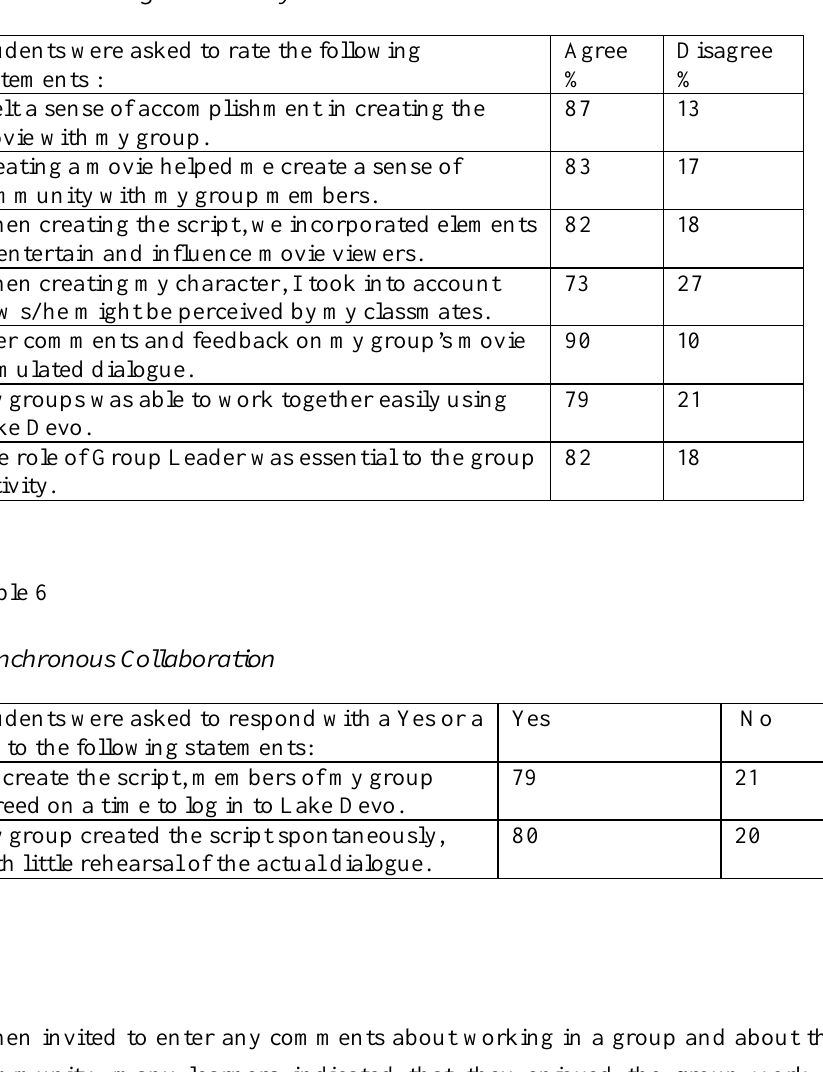
Role of Learning Community